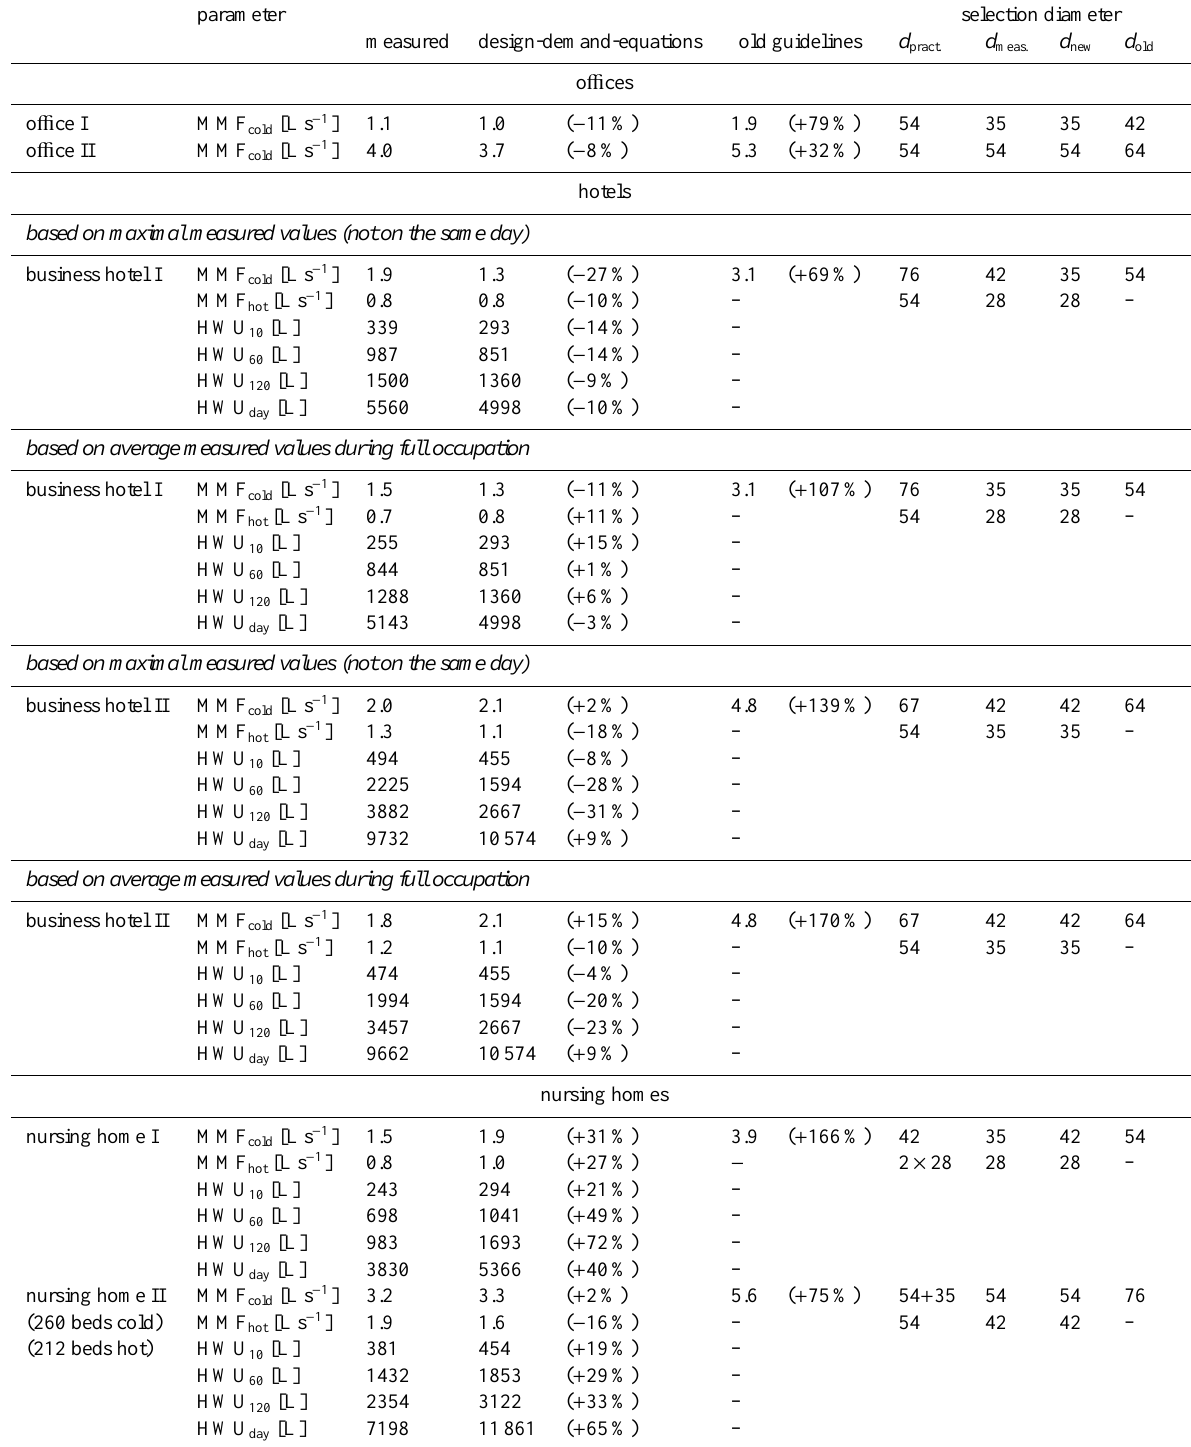
Table 9. Comparison of the measured peak demand values for cold and hot water with the outcome of the SIMDEUM based design-demand- equations (“new”) and existing guidelines for cold water (“old”) for non-residential buildings (o ffi ces, hotels and nursing homes) and the resulting pipe diameters compared with diameters used in practice ( d pract . ). Deviation from measured peak demand values is shown between